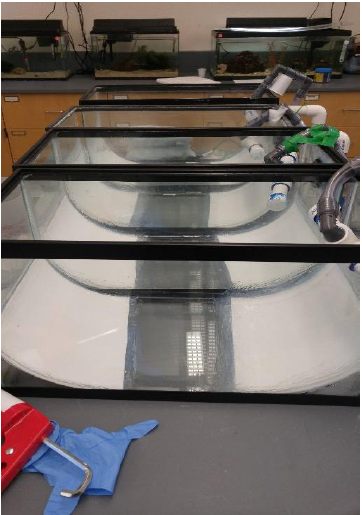
Figure 1. Portrays the plumbing system that goes from the tank to the buckets below .